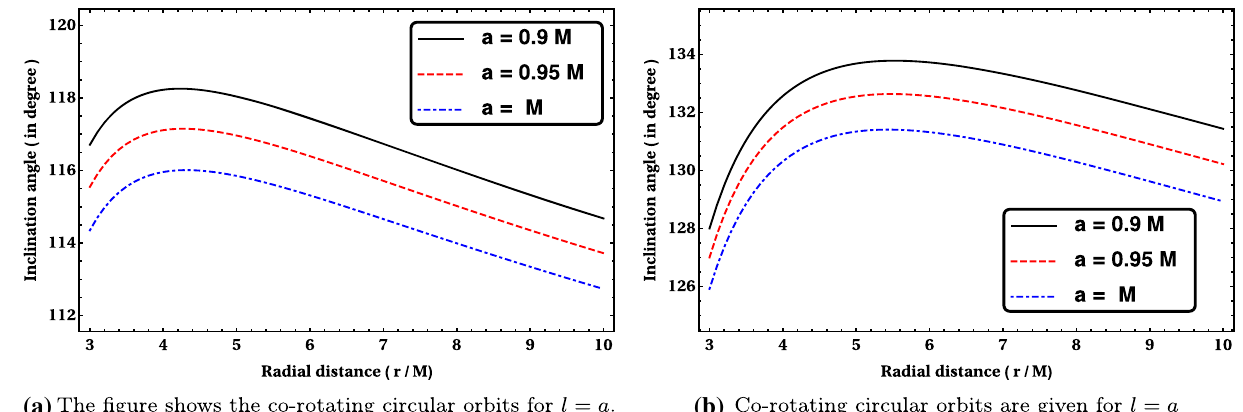
Fig. 3 The angular dependence of the circular orbits are depicted in a Kerr–Newman-NUT black hole satisfying Q 2 = l 2 − a